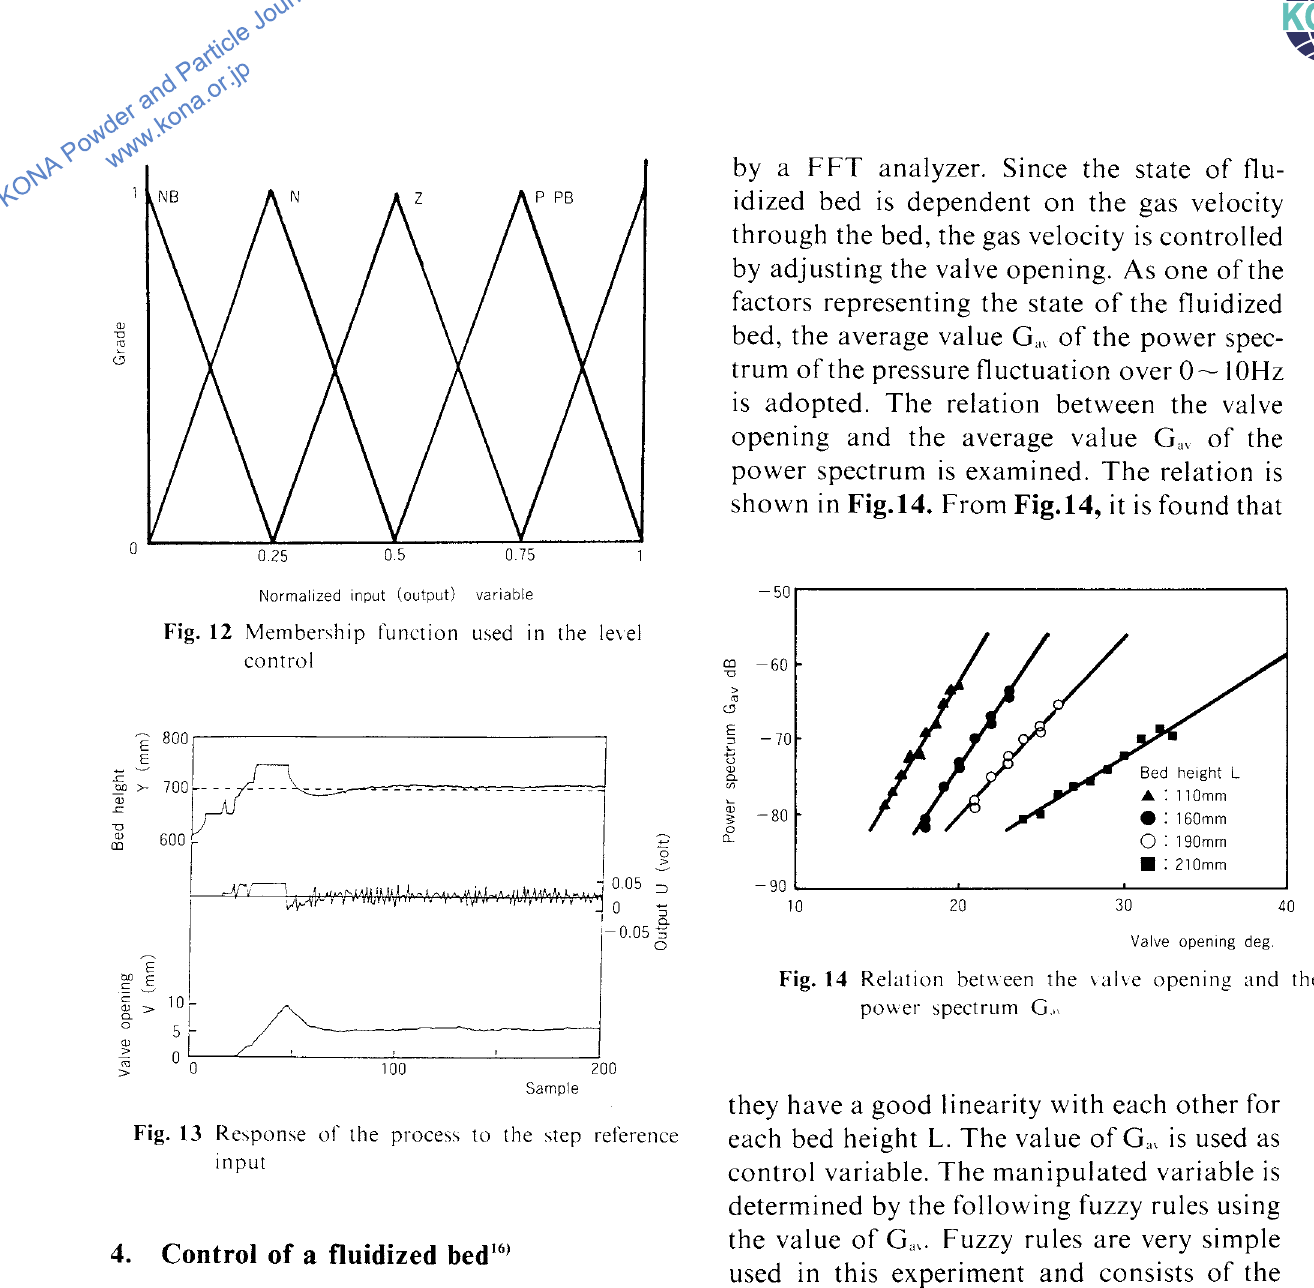
Fig. 13 Re-.pon-.e of the process to the step reference input